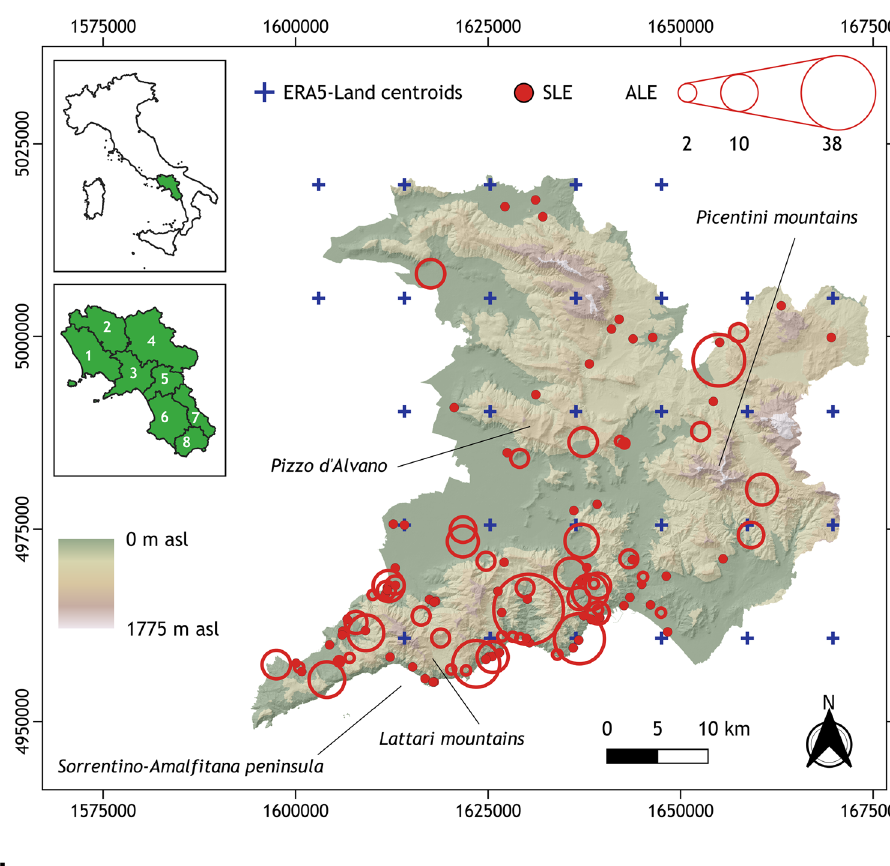
Fig. 1 Map of the Camp-3 alert area depicting the 120 landslides considered in this study and the centroids of the ERA5-Land cells. The insets show the position of the